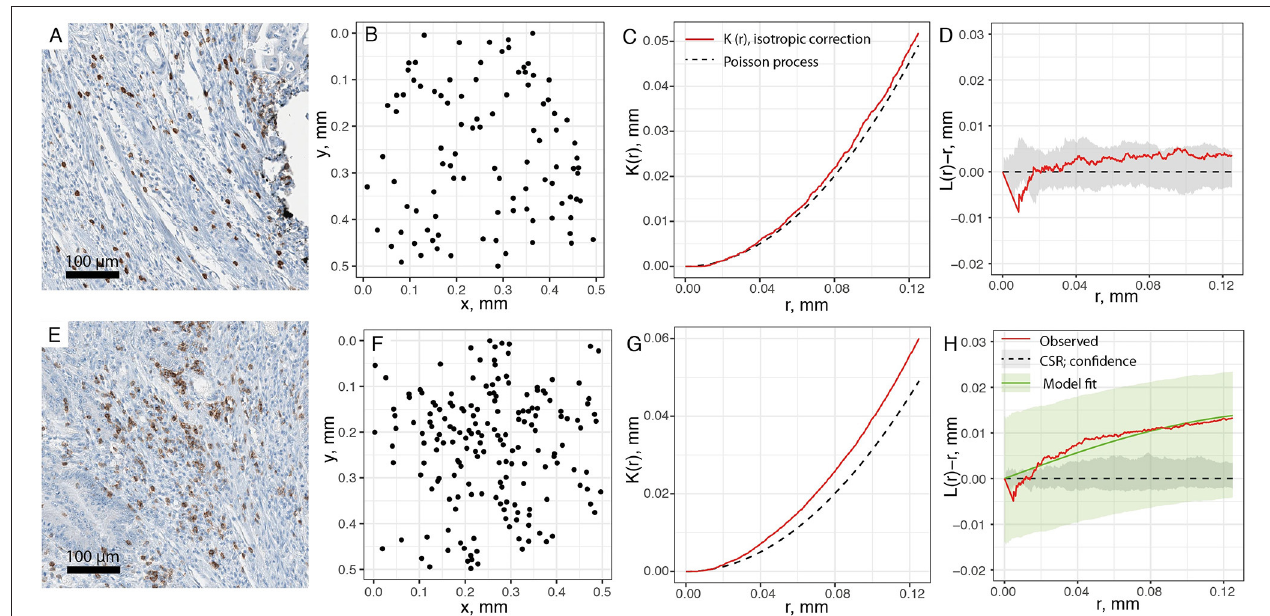
FIGURE 3 | Estimating spatial statistics from sub-regions of point pattern. A moving window is used to quantify sub-regions of each slide, with edge length of 0.5mm and steps of 0.25mm. (A) Original IHC sub-region. (B) Point pattern within the same sub-region. (C) Ripley’s K estimation using isotropic edge correction for pattern in (B) . (D) L-transformation of K function (red). When testing for CSR, no significant aggregation pattern is detected, thus no clustering model fitting is performed for pattern (B) . Black dashed line is theoretical value of L(r)-r for Poisson process (random), and gray envelope is 95% confidence interval obtained from Monte-Carlo simulations. (E–H) is the same process performed over another region. Pattern F is tested as aggregated, and fitted to modified Thomas process model (green line). Green envelope is the global envelope from Dao-Genton goodness-of-fit